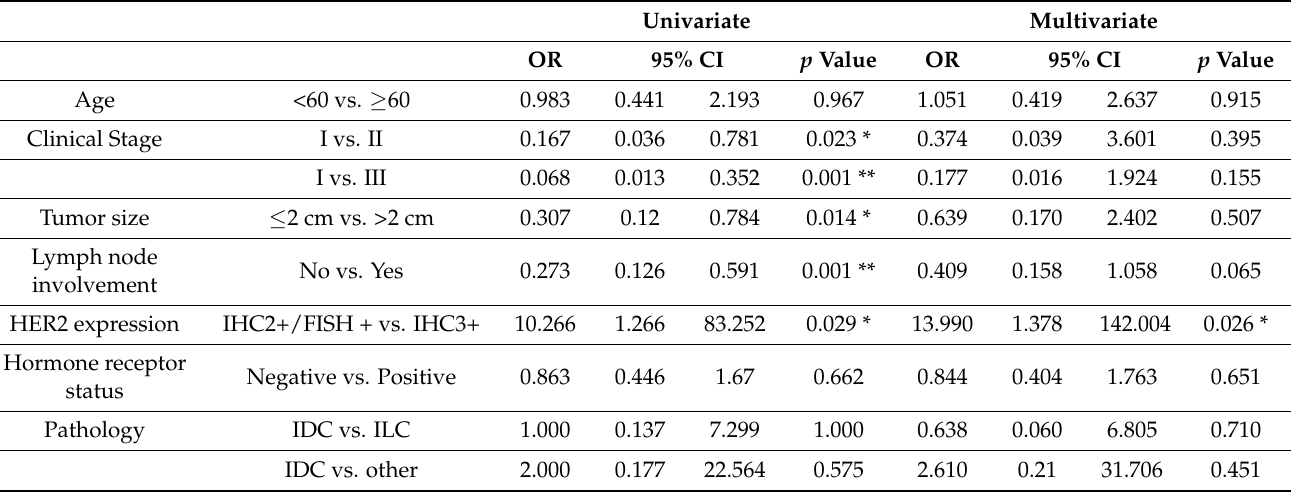
Table 3. Univariate and multivariate analyses of pCR and patients’ characteristics.